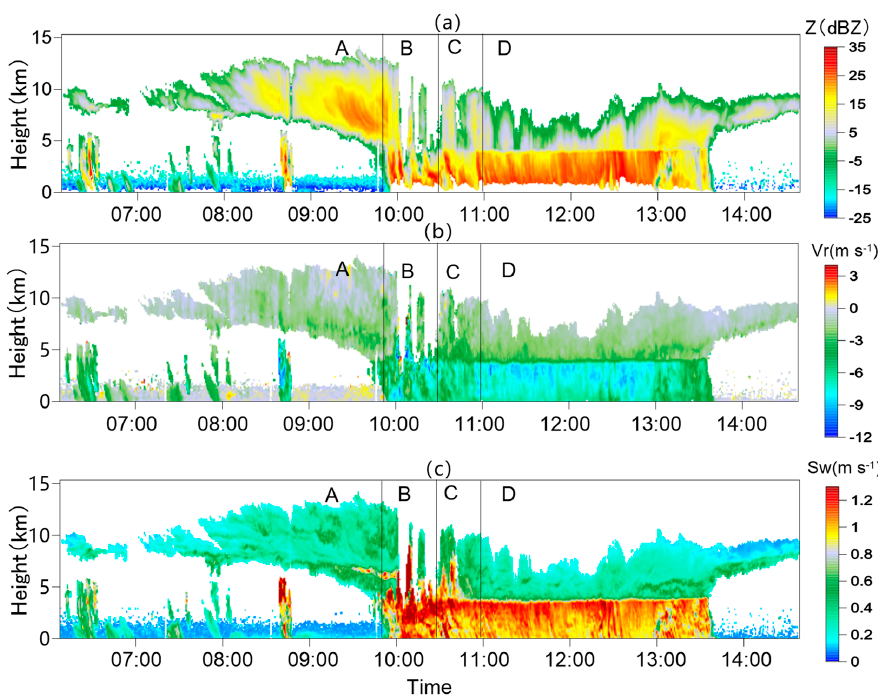
Figure 2. Time–height cross-sections of the squall line echoes observed by CR on May 6, 2016 in precipitation mode: ( a ) reflectivity factor Z (unit: dBZ), ( b ) radial velocity Vr (unit: m s − 1 ), and ( c ) velocity spectrum width Sw (unit: m s − 1 ). Different stages of the squall line are divided by black solid lines, with the time segment before the passage of the squall line, the strong convection time segment, the transition time segment, and the stratiform time segment labeled A, B, C, and D, respectively.